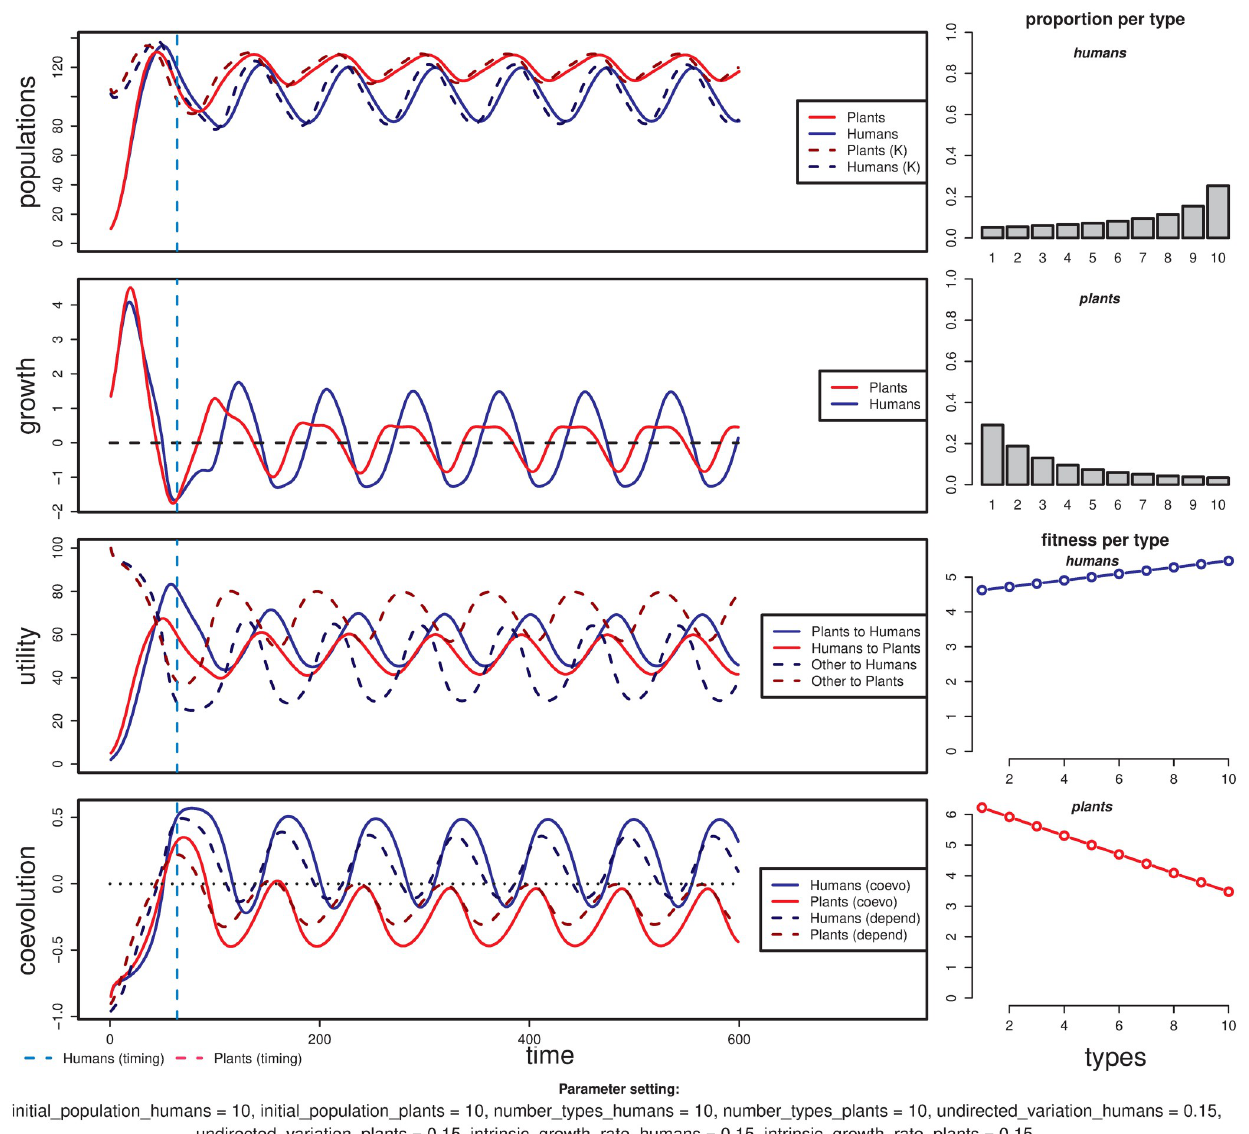
Fig 6. Example of a simulation run with a case of partial oscillatory coevolution where only the human population fully transits to a majority of stronger mutualism types. The timing of this change is marked by the vertical cyan dashed